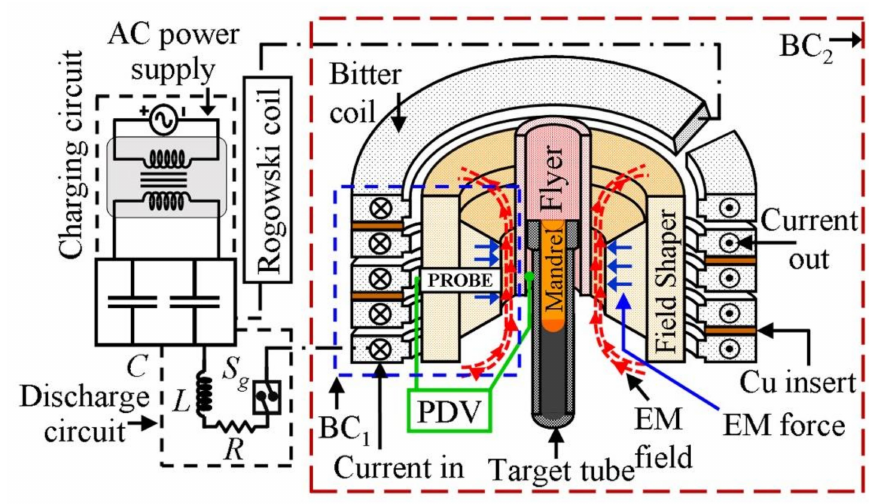
Figure 1. Schematic details of MPW set-up with electrical circuit, coil and overlapped tubes